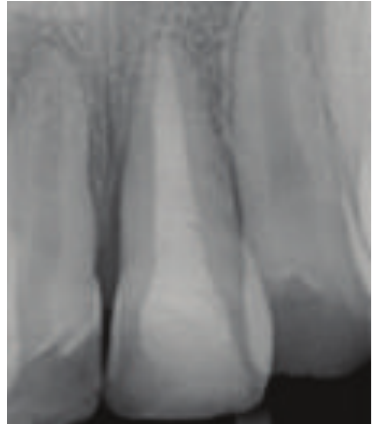
Figure 10: No pathology and resorption, 12-month radiographic